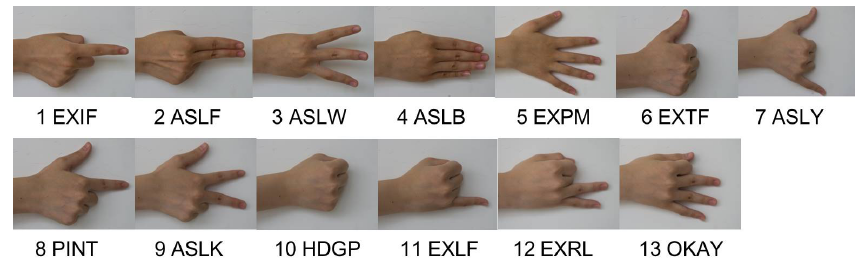
Figure 3. The basic hand shapes with index from 1 to 13.